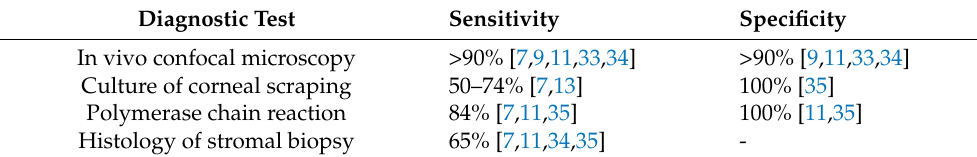
Table 1. Sensitivity and specificity of diagnostic modalities in the diagnosis of Acanthamoeba keratitis. Diagnostic